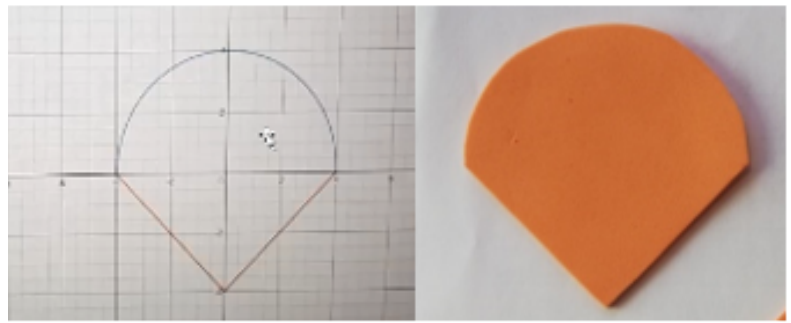
Figure 3. Student drawings of the pieces.